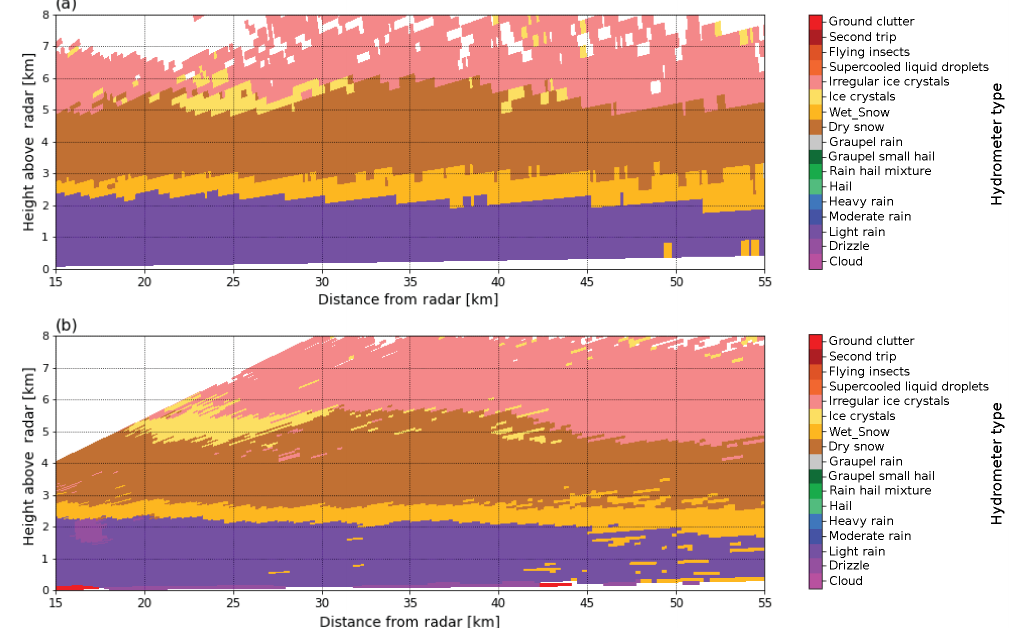
Figure 9. Coincident RHIs from the NXPol (a) and CAMRa (b) on 17 May 2017 at 12:24UTC with the HCA applied to